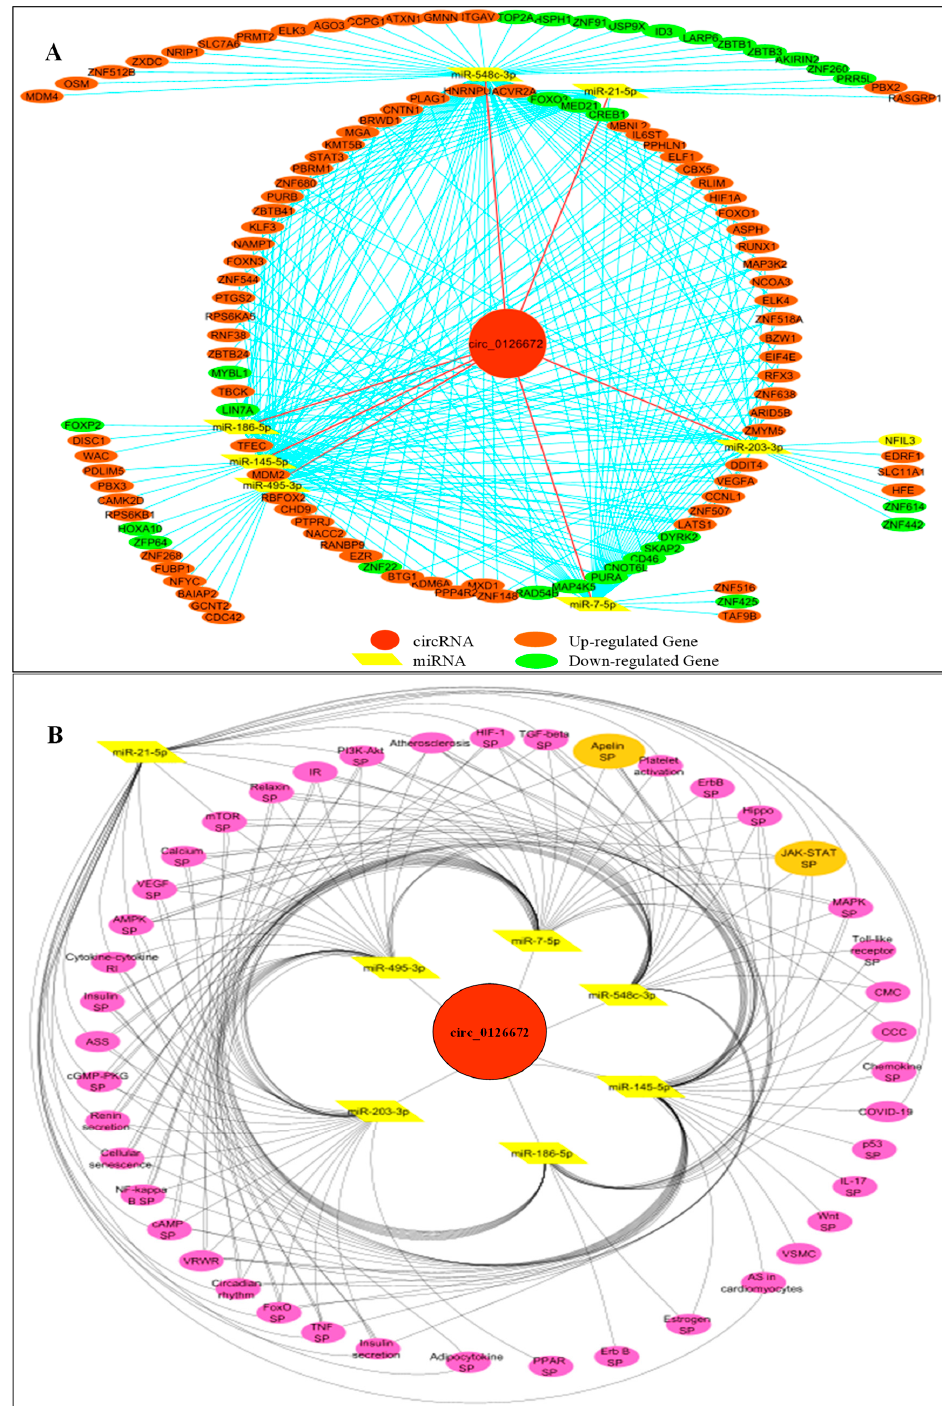
Figure 6. Circular RNA networks. ( A ): hsa_circ_0126672/miRNAs/genes regulatory network in CHD-related biological processes. ( B ): Network interaction between miRNAs and predicted biolog- ical pathways affected by the miR-DEGs. SP: Signaling pathway, IR: insulin resistance, RI: receptor interaction, VRWR: Vasopressin-regulated water reabsorption, CMC: Cardiac muscle contraction, ASS: aldosterone synthesis and secretion, CCC: Complement and coagulation cascades, AS: Adrener- gic signaling, NAFL: Non-alcoholic fatty liver, VSMC: Vascular smooth muscle